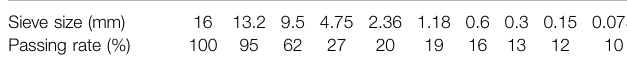
TABLE 1 | The aggregate gradation of mixture (SMA-13). TABLE 2 | Properties of tack coat